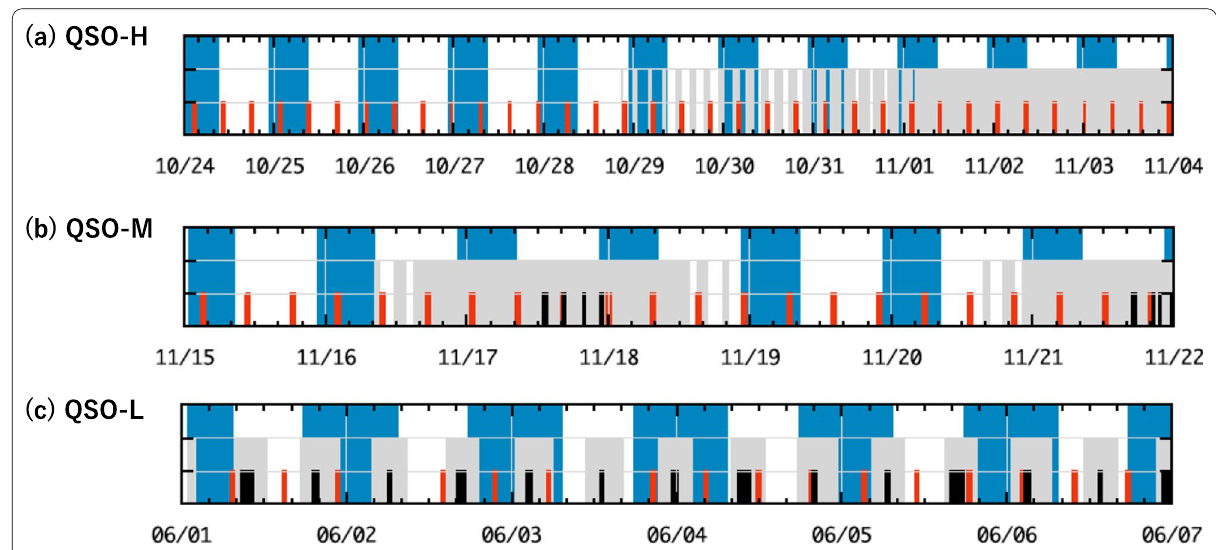
Fig. 4 The occurrence of occultations in a QSO‑H in 12 days, b QSO‑M in 1 week, and c QSO‑LA in 1 week. Blue periods indicate the time when communication from Japan is possible, and gray indicates the time when the spacecraft stays on the night side of Phobos. The red and black periods indicate the occultations by Mars and Phobos,